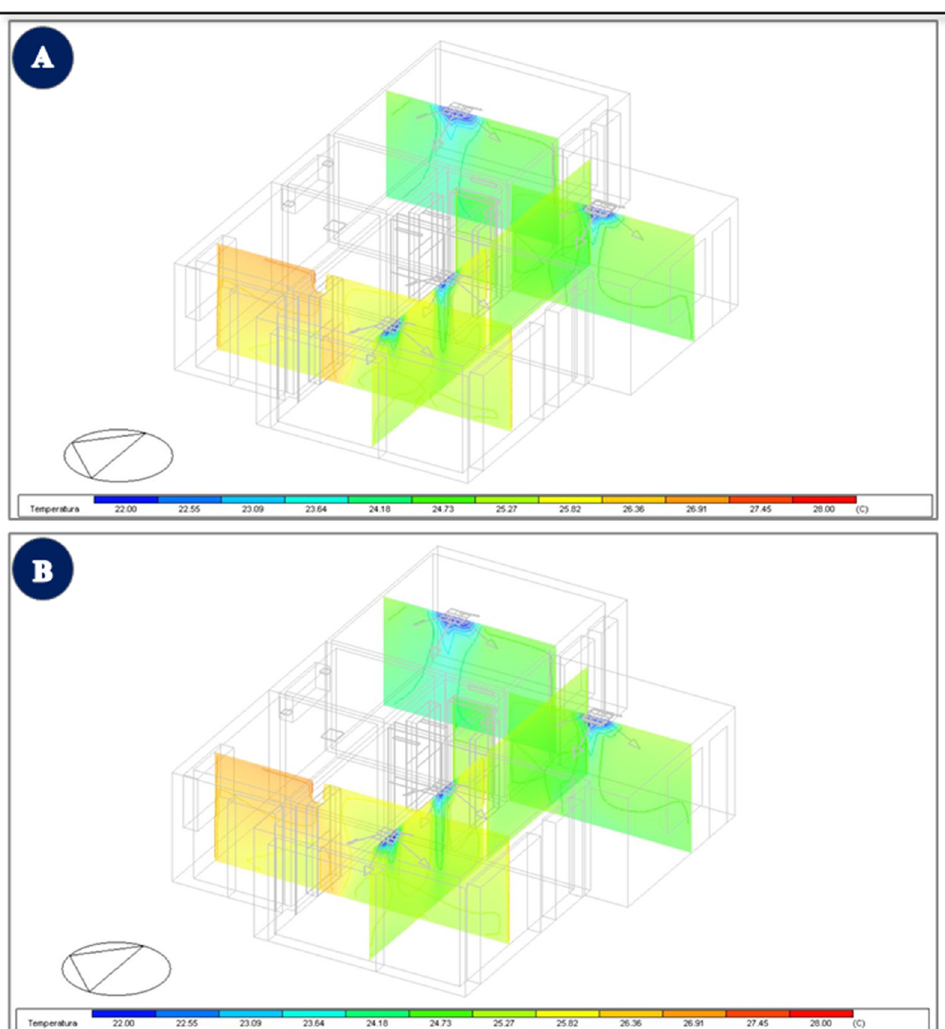
Figure 7. 2D distribution of air temperature on 12 July: ( A ) 14:00 and ( B )